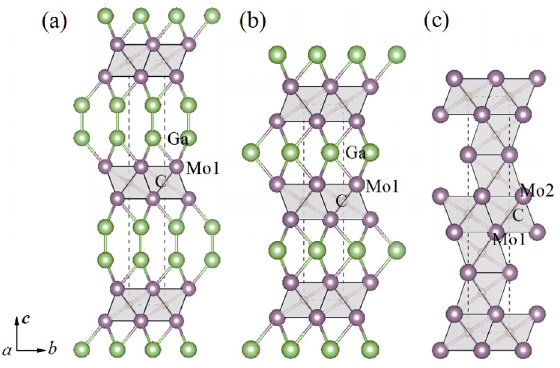
Fig. 1 Crystal structures of (a) Mo 2 Ga 2 C, (b) Mo 2 GaC, and (c) MoC. The purple, green, and brown spheres correspond to the Mo, Ga, and C atoms, respectively.